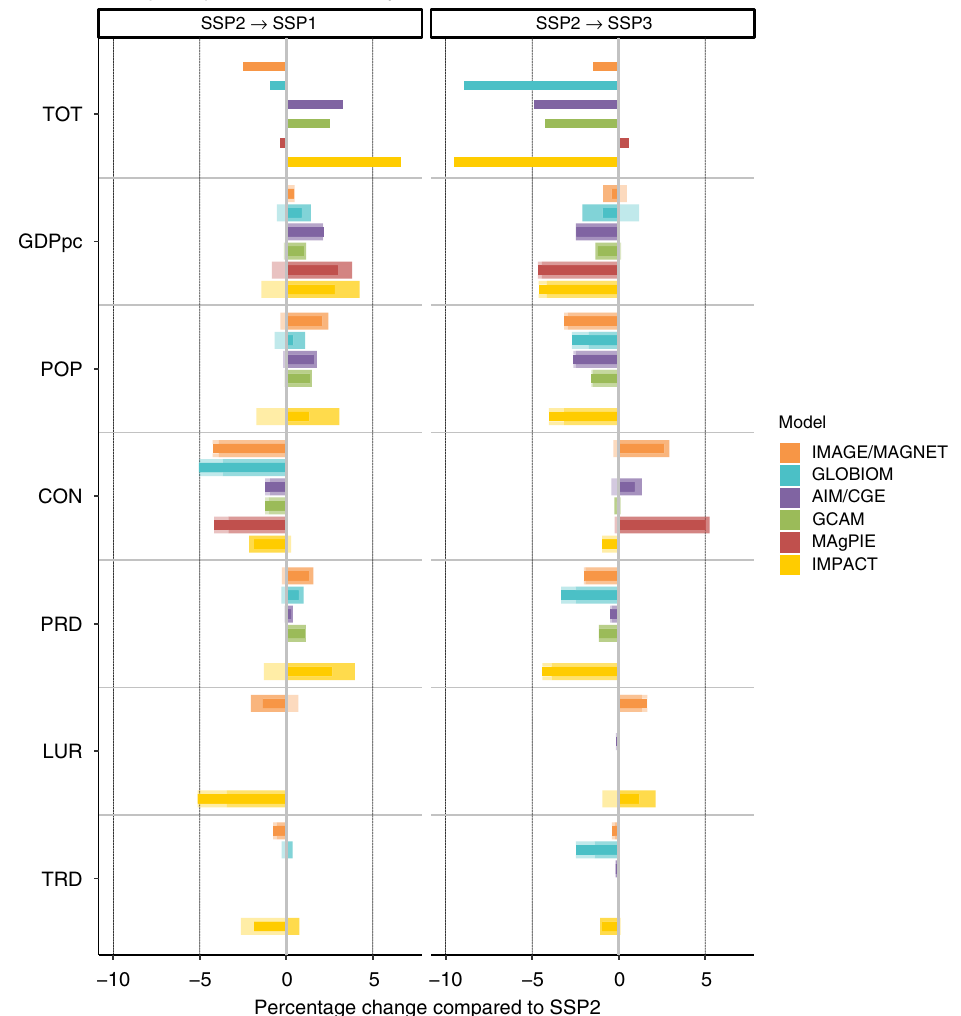
Fig. 3 Sensitivity of consumption per capita to groups of drivers. Changes refer to consumption change in 2050 when moving from SSP2 to either SSP1 (SSP2- > SSP1) or SSP3 (SSP2- > SSP3). Individual effects (wide, light-colored bars), fi nal effects (thin, dark-colored bars), and interaction effects (wide, very-light-colored bars) are shown for each of the six driver groups (CON: consumption preference, GDPpc: economic development, LUR: land-use regulation, POP: population, PRD: agricultural productivity growth, TRD: trade development), together with the total difference between SSP1 and SSP3, respectively, and SSP2